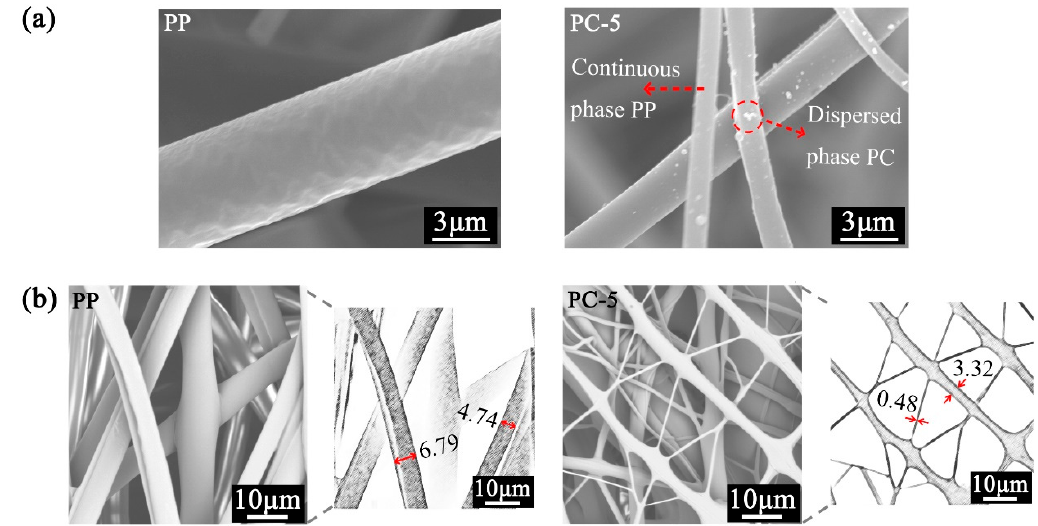
Figure 5. The viscosity curves of PP and PC.